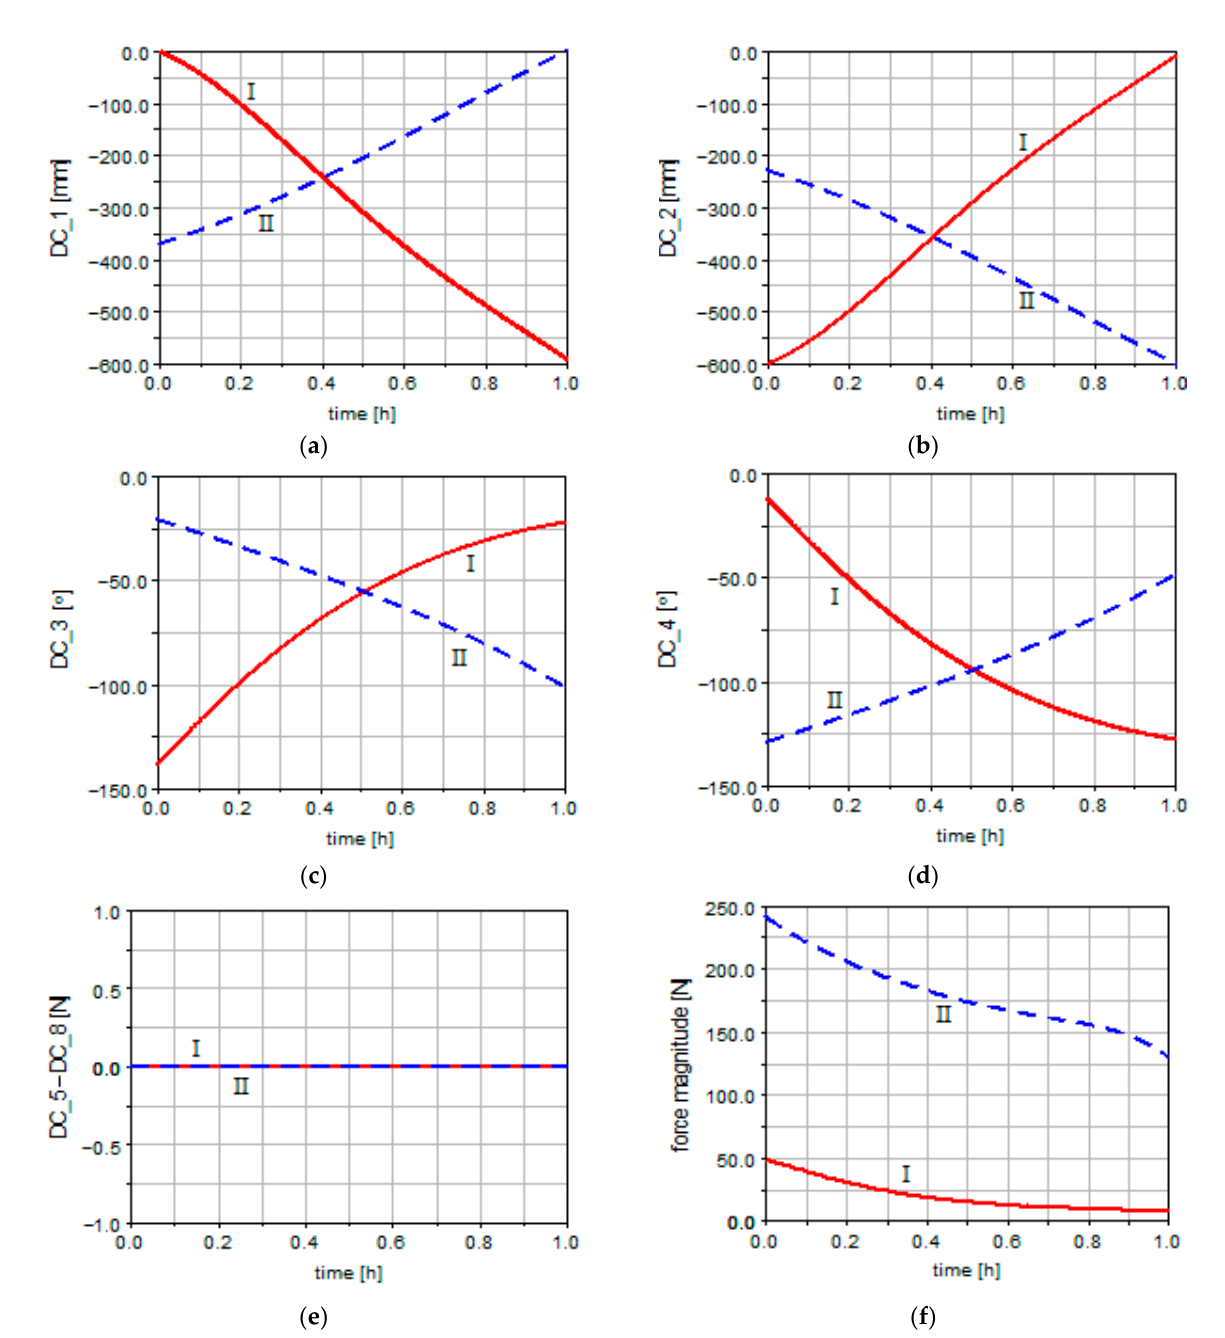
Figure 8. Results of the optimal tracking system simulation: ( a – e ) Design constraints, ( f ) Objective functions.